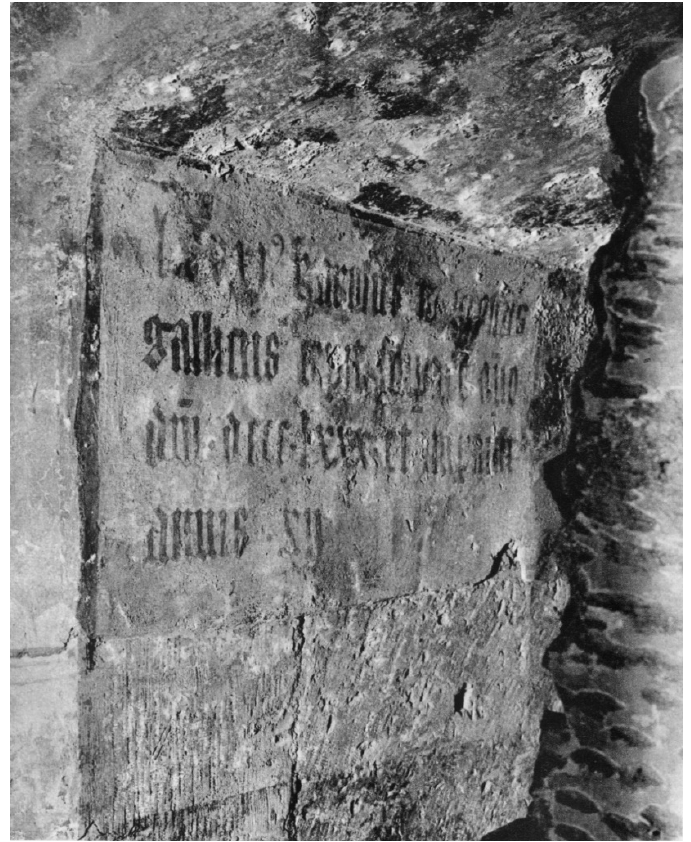
Figure 3. Prague Castle, Vladislav Hall. Fragment of inscription mentioning Charles III, from the cycle of emperors. Third quarter of the 14th century. Published by (Borkovský et al. 1946, unpaged, public domain).